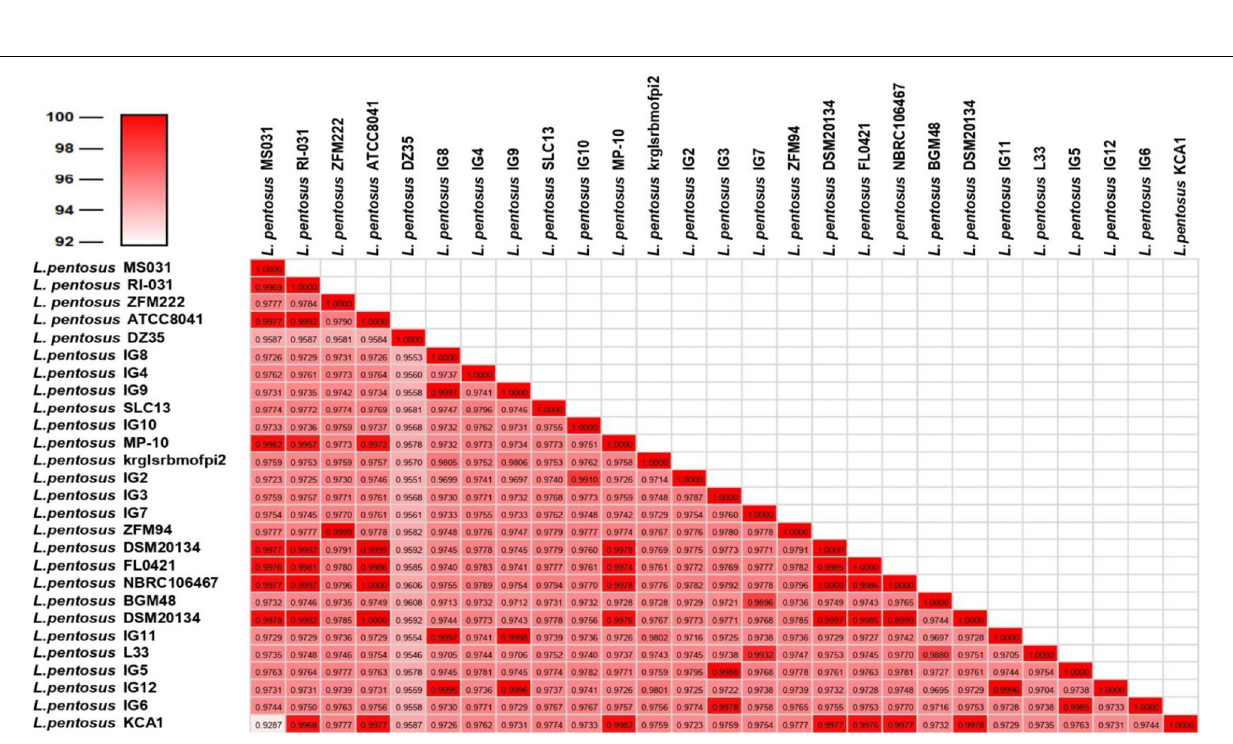
FIGURE 3 | Average Nucleotide Identity scores among all 27 L. pentosus